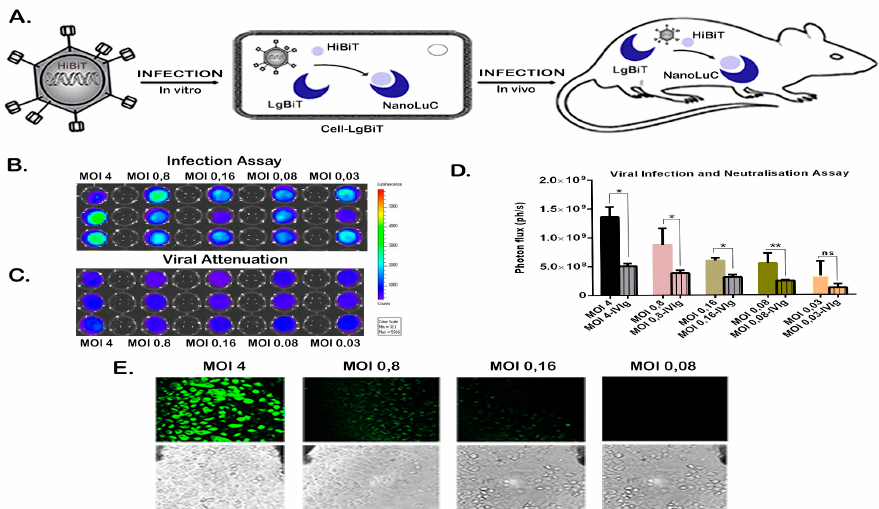
Figure 1. Detection of HiBiT-reporter in vitro. ( A ) Schematic representation of NanoBiT system applied for imaging of viral infection in vivo and in vitro. Bioluminescence in vitro imaging of HiBiT-reporter virus infection by applying the NanoBiT system ( B , C ). PC-3-LgBiT cells were infected with: ( B ) HiBiT-reporter virus or ( C ) with neutralized HiBiT-reporter virus by pre-incubation with intravenous immunoglobulin G (IvIg). The HiBiT-reporter virus infection was performed with several dilutions of viral stock (ranging from 4 to 0.03 MOI). The virus-exposed cells were imaged 24 h post infection by addition of substrate from the Nano-Glo Luciferase Assay System with a final concentration of 0.01 mm. ( D ) Signals were quantified with IVIS software. Quantification of detected signal as correlation between detected light and viral infectivity after background subtraction. Results are presented as means + SD. Data are significant di ff erent (one-way ANOVA F-value of 30.16) and the signal of infected cells is significantly di ff erent from the neutralization assay (* p -value < 0.01, ** p -value < 0.001) ( E ) Fluorescence microscopy of PC-3-LgBiT cells infected with di ff erent HiBiT-GFP-reporter virus dilutions (varying from 4 to 0.03 MOI). For checking the transfection rate using the GFP signal, fluorescence was detected 24 h post infection. Size of the scale bar is 2 µ